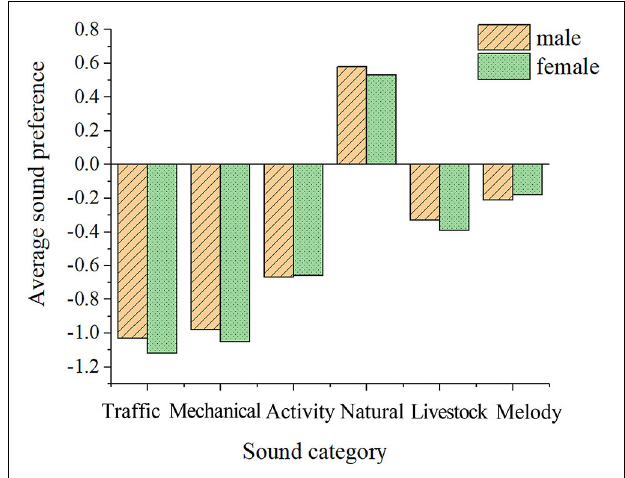
FIGURE 5 | Average soundscape preference of people of different genders.